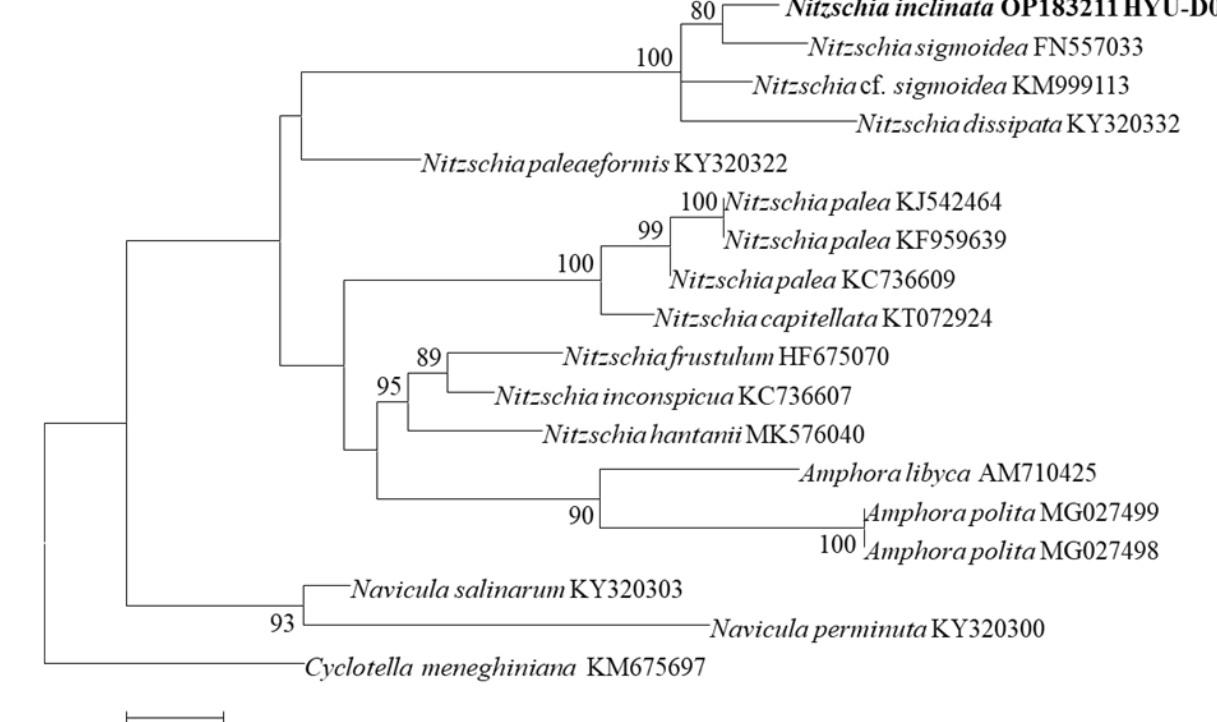
Figure 12. SSU rRNA phylogenetic tree by maximum likelihood method of Nitzschia inclinata sp. nov. and other species molecular position. The tree with the highest log likelihood ( − 4374.77) is shown. The percentages of trees in which the associated taxa clustered together are shown next to the branches. The analysis involved 20 nucleotide sequences and 1392 positions in the final data set. Cyclotella meneghiniana was used as the outgroup.